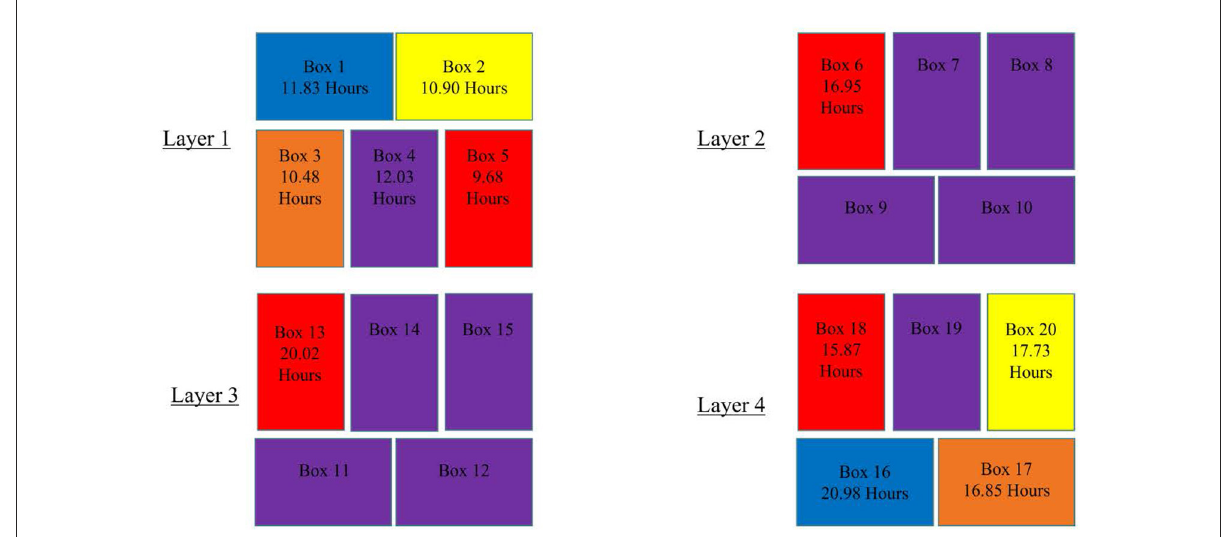
FIGURE7 Thermal images of all sides of a pallet of chicken breasts immediately after being removed from a walk-in cooler (4 ◦ C).